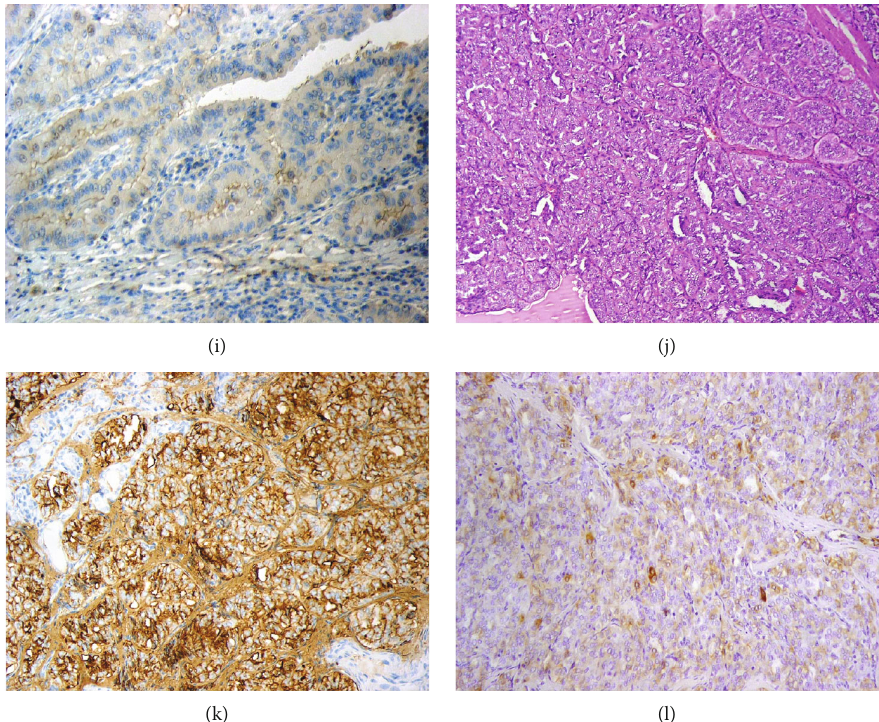
Figure 2: Papillary thyroid carcinoma (PTC) cases. Classic variant of PTC (H&EX100) (a). A case of classic PTC showing high SLC34A2 IHC expression (IHCX100) (b). Another case of classic PTC showing low SLC34A2 (IHCX200) (c). Follicular variant of PTC (H&EX200) (d). A case of follicular variant of PTC showing high SLC34A2 IHC expression (IHCX200) (e). Another case of follicular variant of PTC showing low SLC34A2 IHC expression (IHCX200) (f). Tall cell variant of PTC (H&EX200) (g). A case of tall cell variant of PTC showing high SLC34A2 IHC expression (IHCX200) (h). Another case of tall cell variant of PTC showing low SLC34A2 IHC expression (IHCX200) (i). Solid variant of PTC (H&EX100) (j). A case of solid variant of PTC showing high SLC34A2 IHC expression (IHCX200) (k). Another case of solid variant of PTC showing low SLC34A2 IHC expression (IHCX100)